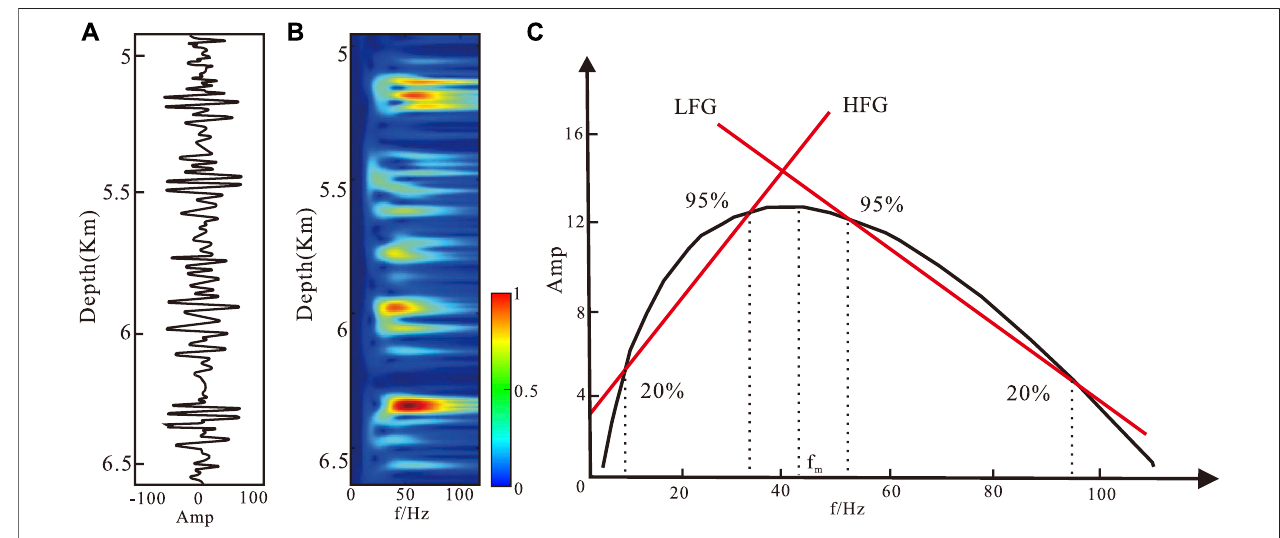
FIGURE4| DiagramoftheEAAcalculationmethodinthedepthdomain. (A) Deepseismicgathers; (B) depthtime – frequencyanalysisdiagram; (C) EAAextraction